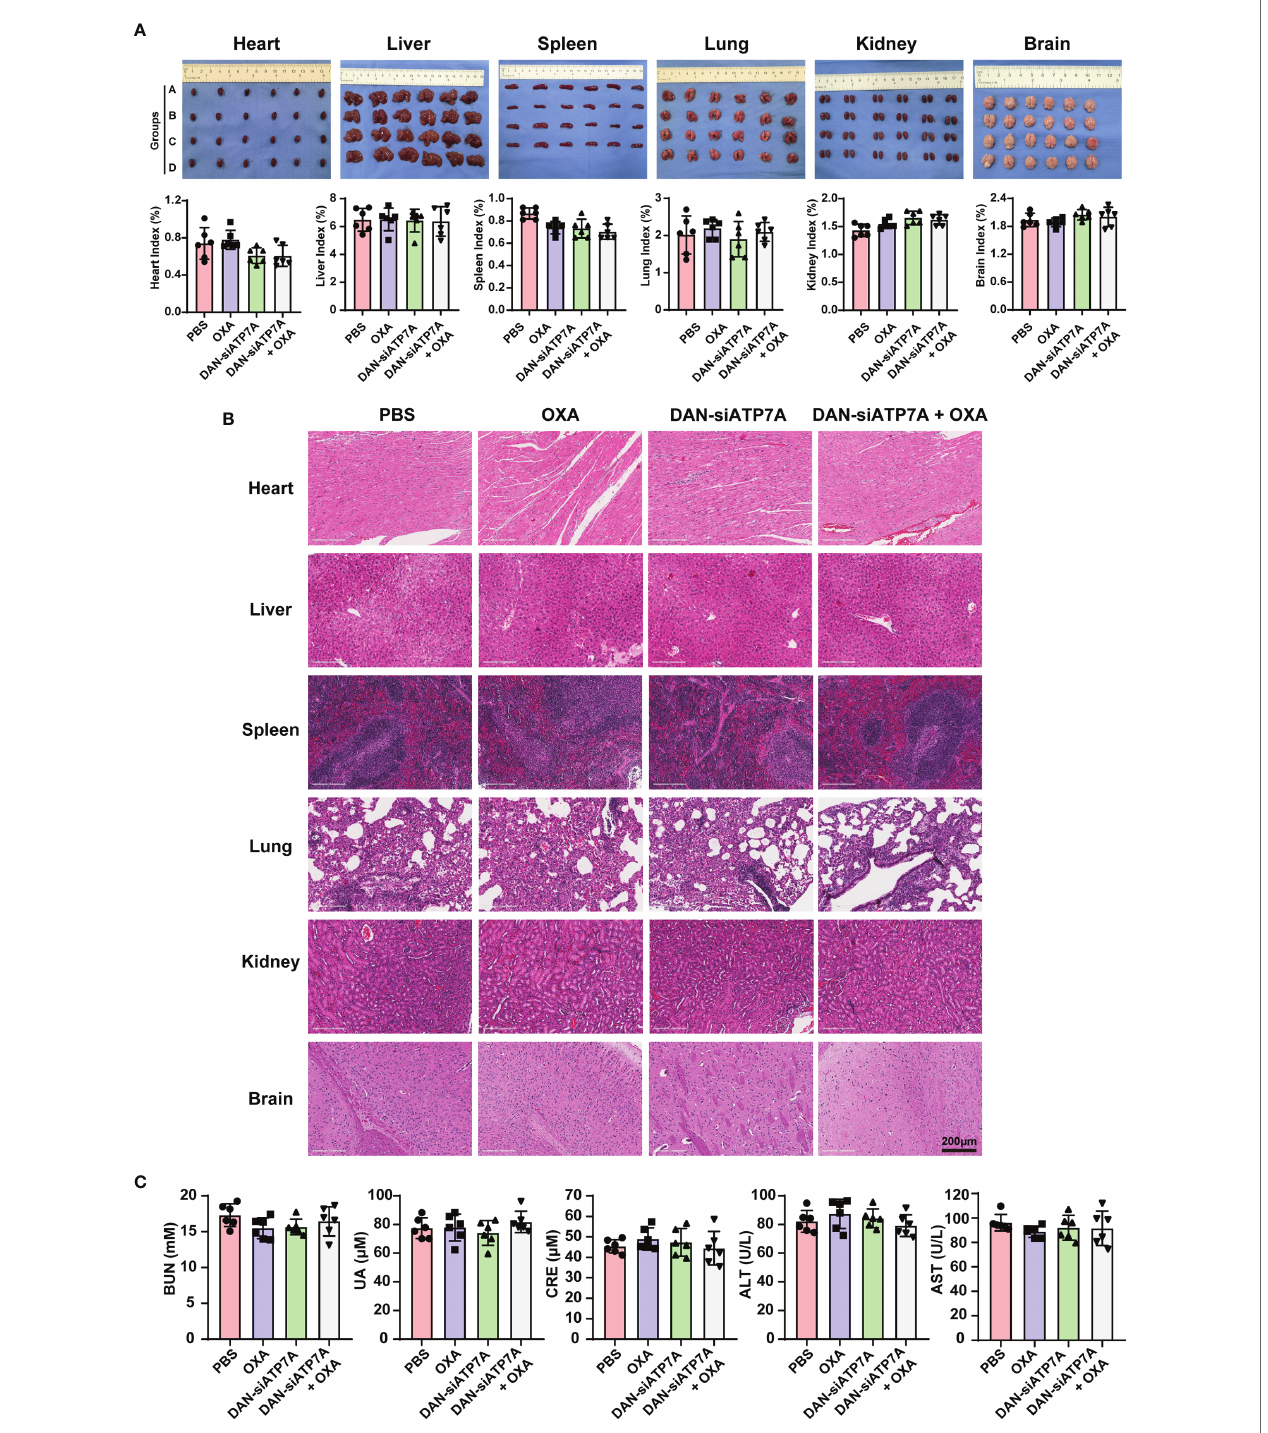
FIGURE 6 | In vivo toxicity analysis. (A) The image of organs including heart, liver, spleen, lung, kidney, and brain from the nude mice at the end of the in vivo study and the organ index (organ index = the weight of the organ/the weight of the mice) of the nude mice. Data were expressed as means ± SD. Group A stands for PBS; Group B stands for OXA; Group C stands for DAN-siATP7A and Group D stands for DAN-ATP7A + OXA. (B) The HE staining of organs. (C) The blood test of ALT, AST, BUN, Cr, UC of the nude mice, and no toxicity were found in our in vivo